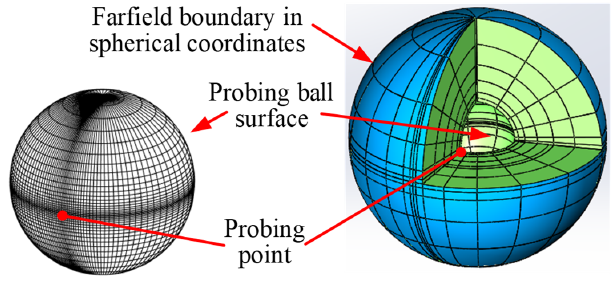
Figure 4. Schematic diagram of nonuniform gridding in spherical coordinates.